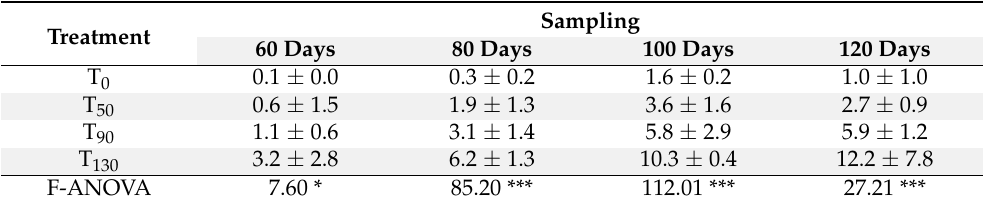
Table 10. Zinc content ( µ g/L) in leachates. Entries represent means ± standard errors from n = 3 replicates.